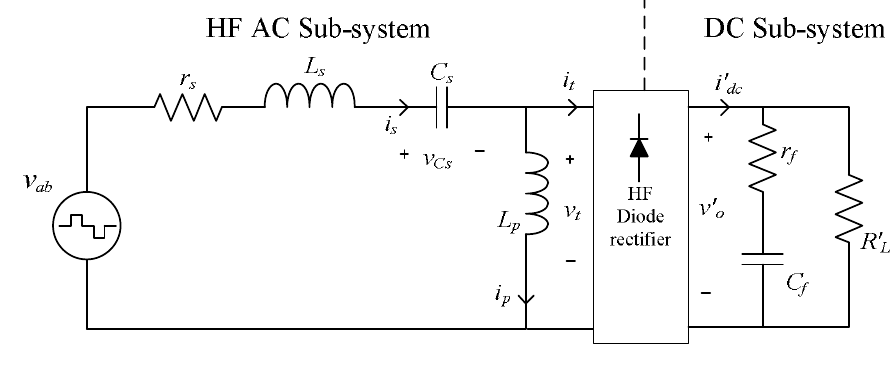
Figure 3. A two-stage equivalent